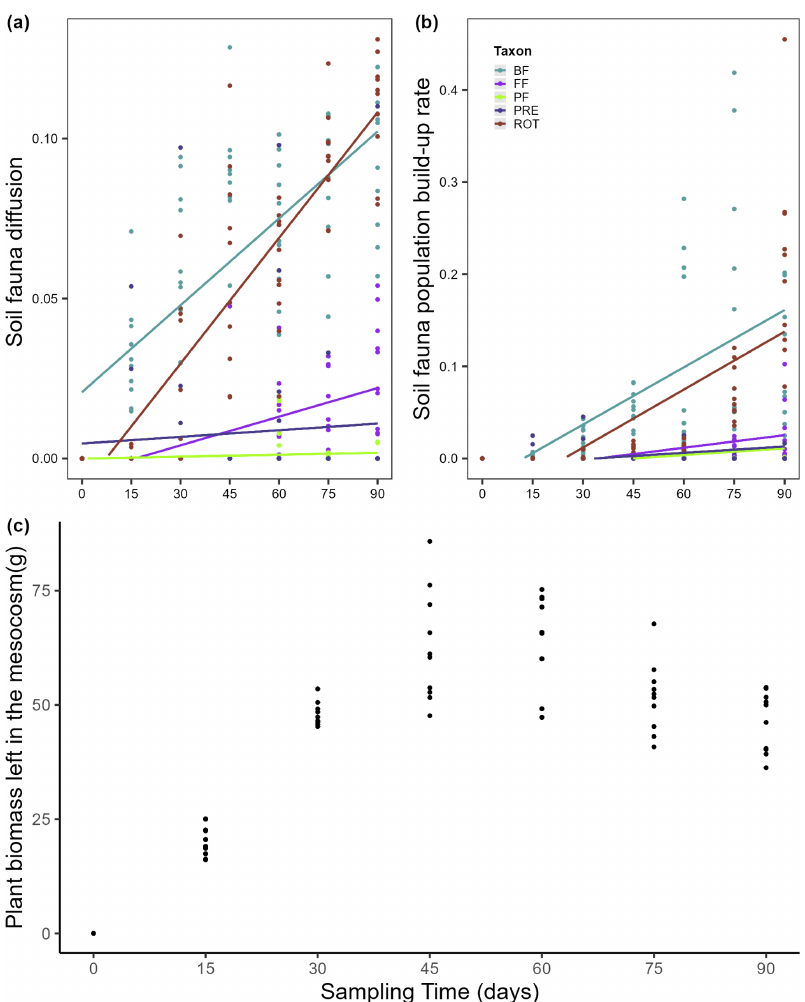
Figure 2. Dispersal of soil fauna functional groups and plant biomass over time (0–90d). The seven sampling times include the time of inoculation. There were 15d in between sampling times. (a) Diffusion and (b) population build-up rates of each soil fauna functional group; (c) total biomass of the A. stolonifera plants present in the mesocosm. BF: bacterial-feeding nematodes; FF: fungal-feeding nematodes; PF: plant-feeding nematodes; PRE: predatory nematodes; ROT: rotifers. Lines here indicate the predicted diffusion for a mean regularity and population build-up rate for a mean regularity and mean aboveground plant biomass per functional type of nematodes and rotifers across